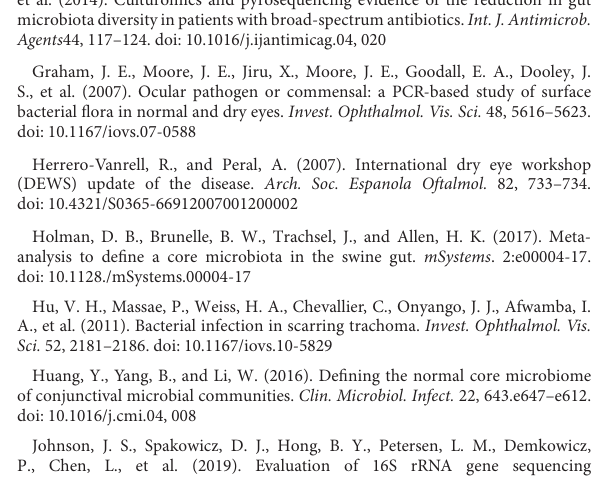
SUPPLEMENTARYTABLE3 Statistical table of pathogenicity analysis of strains isolated and cultivated on the ocular surface. SUPPLEMENTARYTABLE4 Basic information of